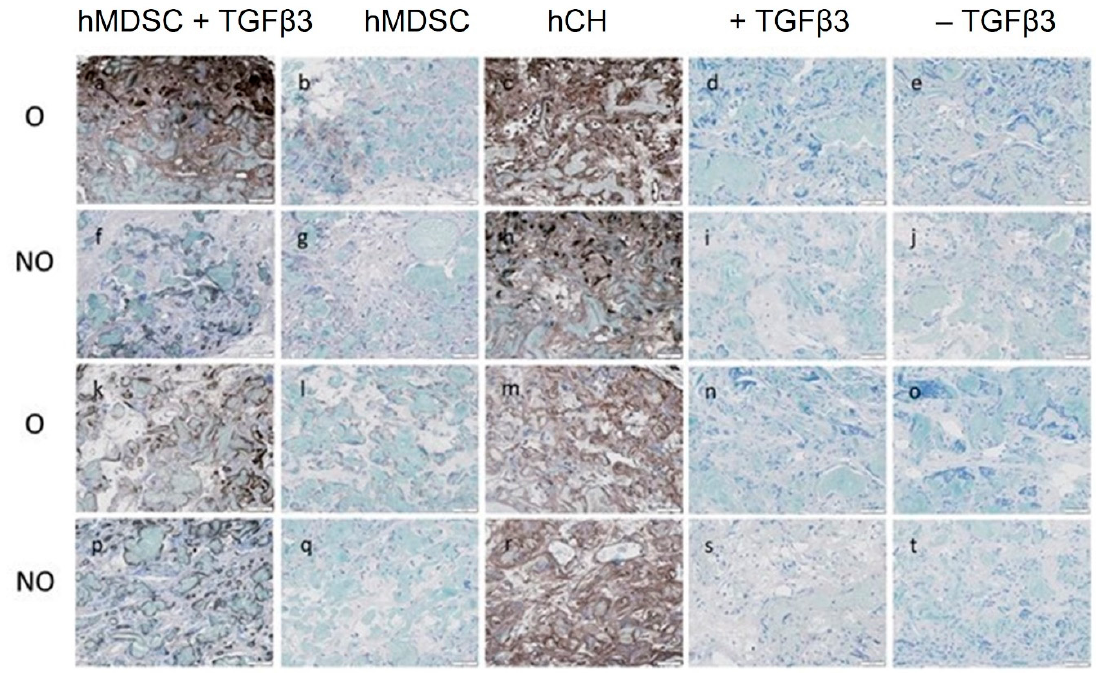
Figure 7. Coll2 expression in O and NO scaffolds in vivo after 4 weeks ( a – j ) and 8 weeks ( k – t ). Cell-free scaffolds (d,e,i,j,n,o,s,t). NO—untreated, O—ozone-treated, hMDSC—human-muscle-derived stem cells, hCH—human chondrocytes, TGF β 3—transforming growth factor beta-3. Scale bar—50 μ m.